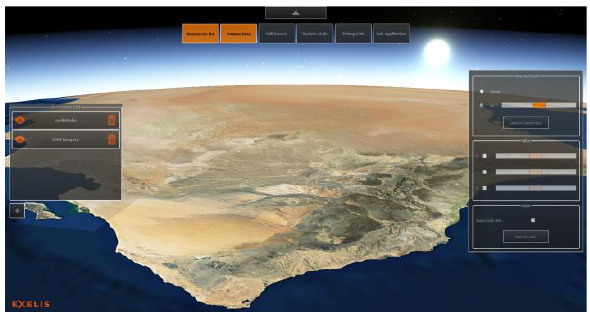
Figure 1 - EarthScape HMI with